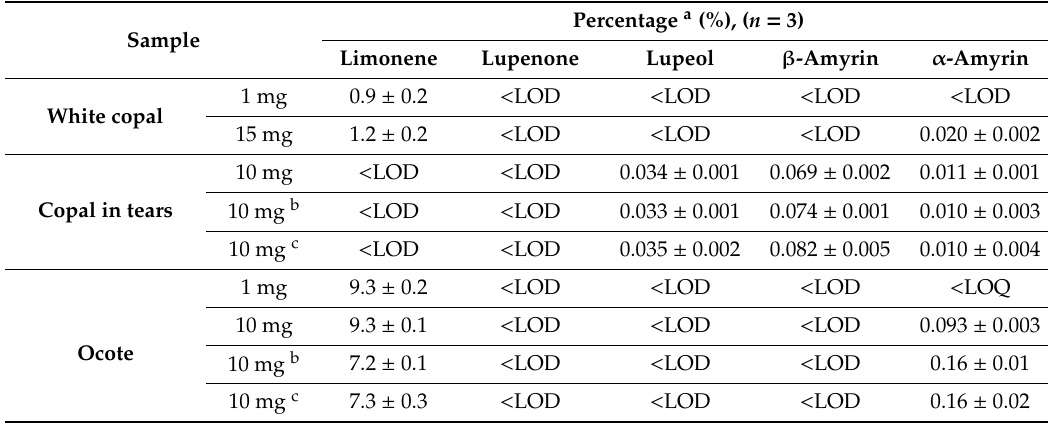
Table 3. Percentages * of the analytes found in the analyzed resin samples ( n = 3). Sample